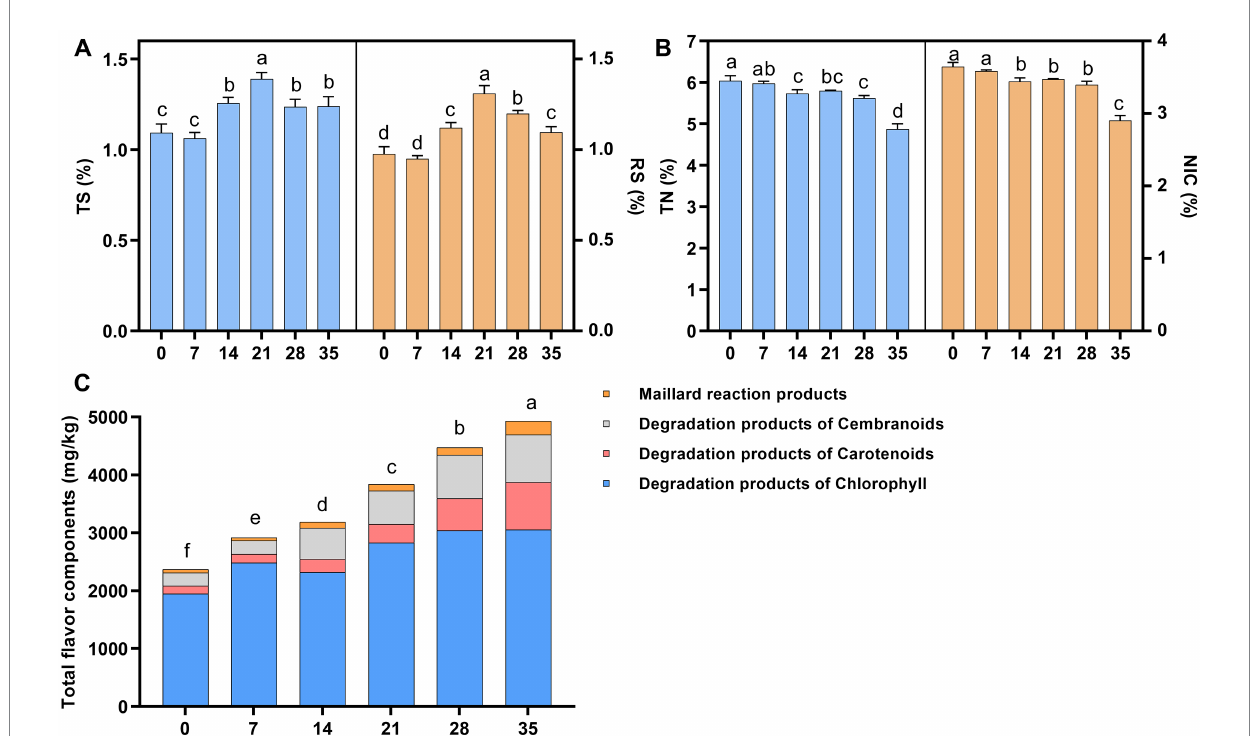
FIGURE 1 The changes of physicochemical metabolites during fermentation of cigar tobacco leaves. (A) Total sugar and reducing sugar content; (B) total nitrogen (TN) and alkaloid (NIC) content; (C) flavor component content. TS, total sugar; RS, reducing sugar; TN, total nitrogen; NIC, alkaloid. Letters indicated significant differences based on Turkey’s LSD, and the numbers 0, 7, 14, 21, 28, 35 indicated the fermentation